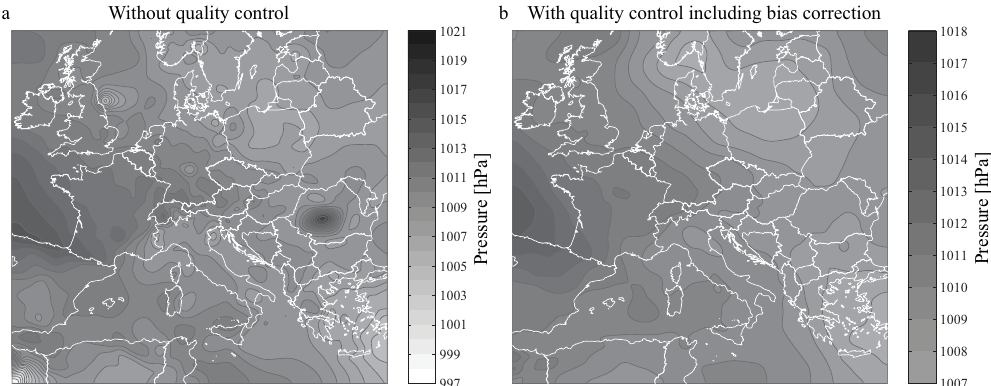
Fig. 9. Comparison of monthly mean values of the analyzed hourly MSL-pressure observations for July 2011 without QC (a) and with QC including bias correction (b) . The hourly measurements have been analyzed with the help of the analysis tool VERA, the monthly mean values are based on the gridded data. Systematic errors, especially those with high magnitude (e.g. caused by reduction errors), have been corrected. As a result, the mean gridded values in (b) are distributed more